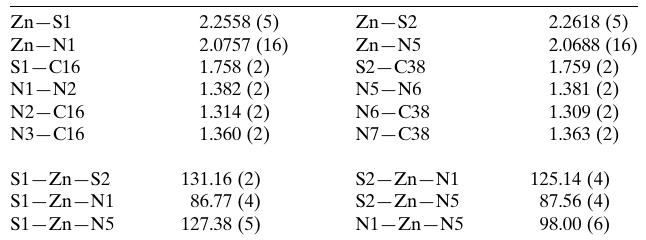
Table 1 Selected geometric parameters (A˚ , (cid:2) ).